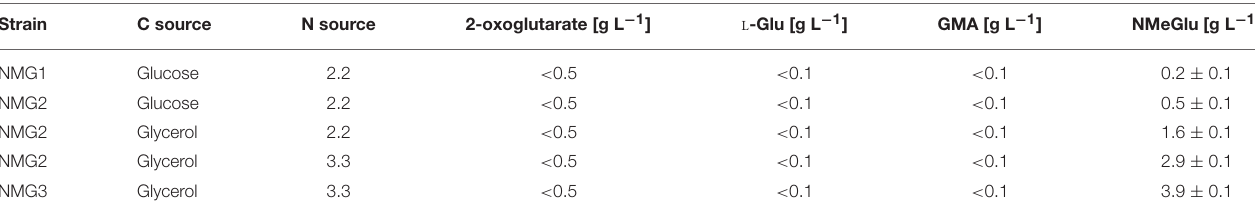
TABLE 2 | Production of P. putida KT2440 strains.